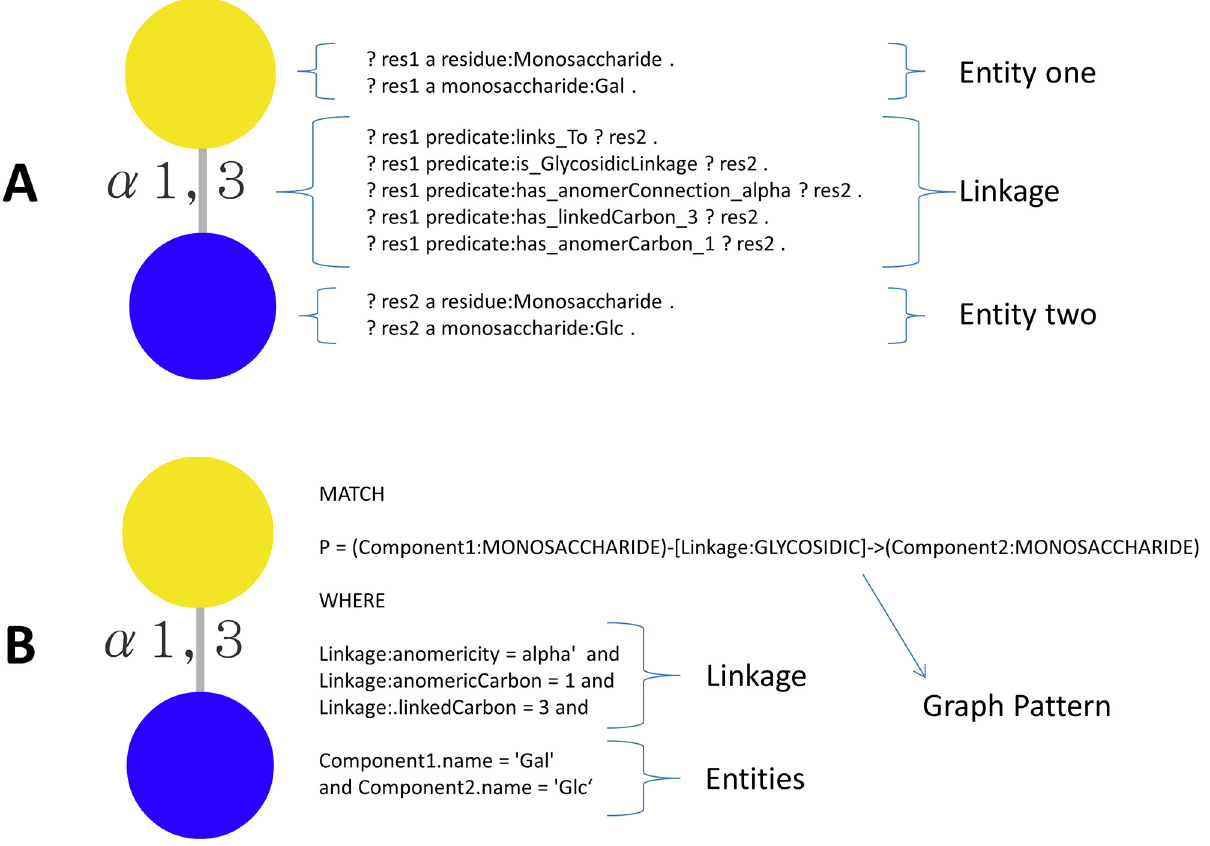
Fig 3. Query building example. A. Example of use of the RDF model to build a SPARQL query from a glycan substructure focussing on the translation process. The prefix part of the query is omitted but further detailed examples are provided in the S1 File. B. The same example is shown with building a Cypher query, the native language in Neo4J. Similarly, additional examples are provided in the S1